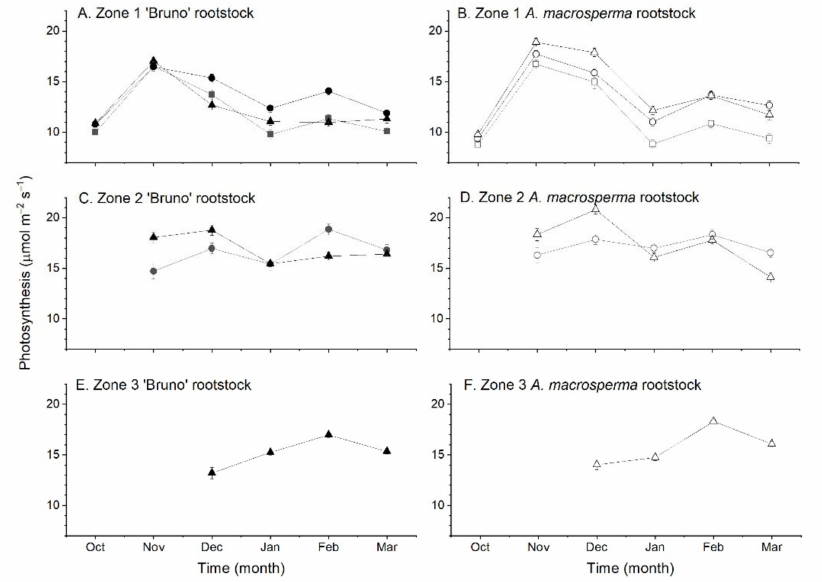
or long (cid:52) shoots). (cid:35)